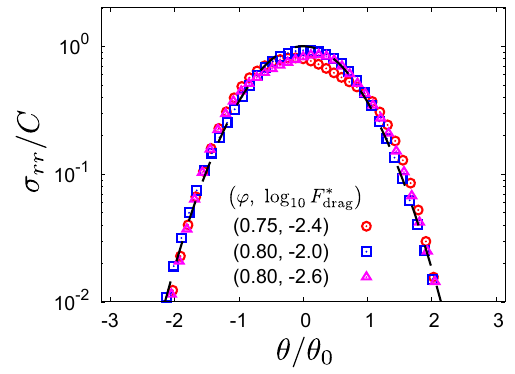
≡ F drag / ( k n d ) drag